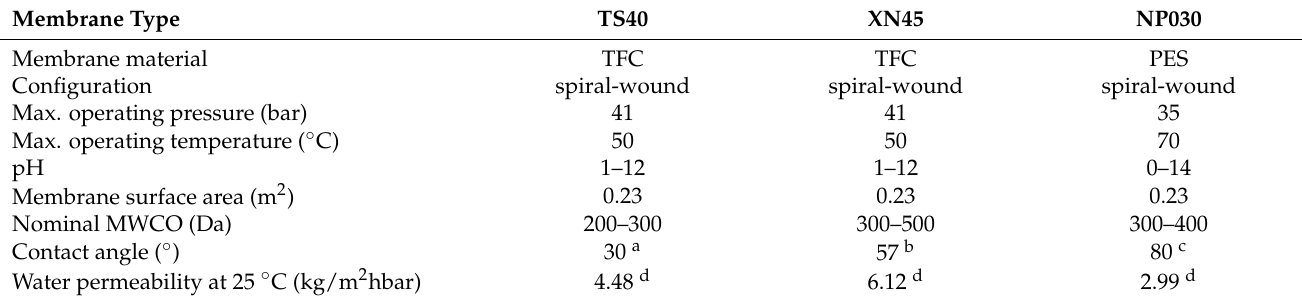
Table 2. Characteristics of selected membranes according to manufacturers unless otherwise